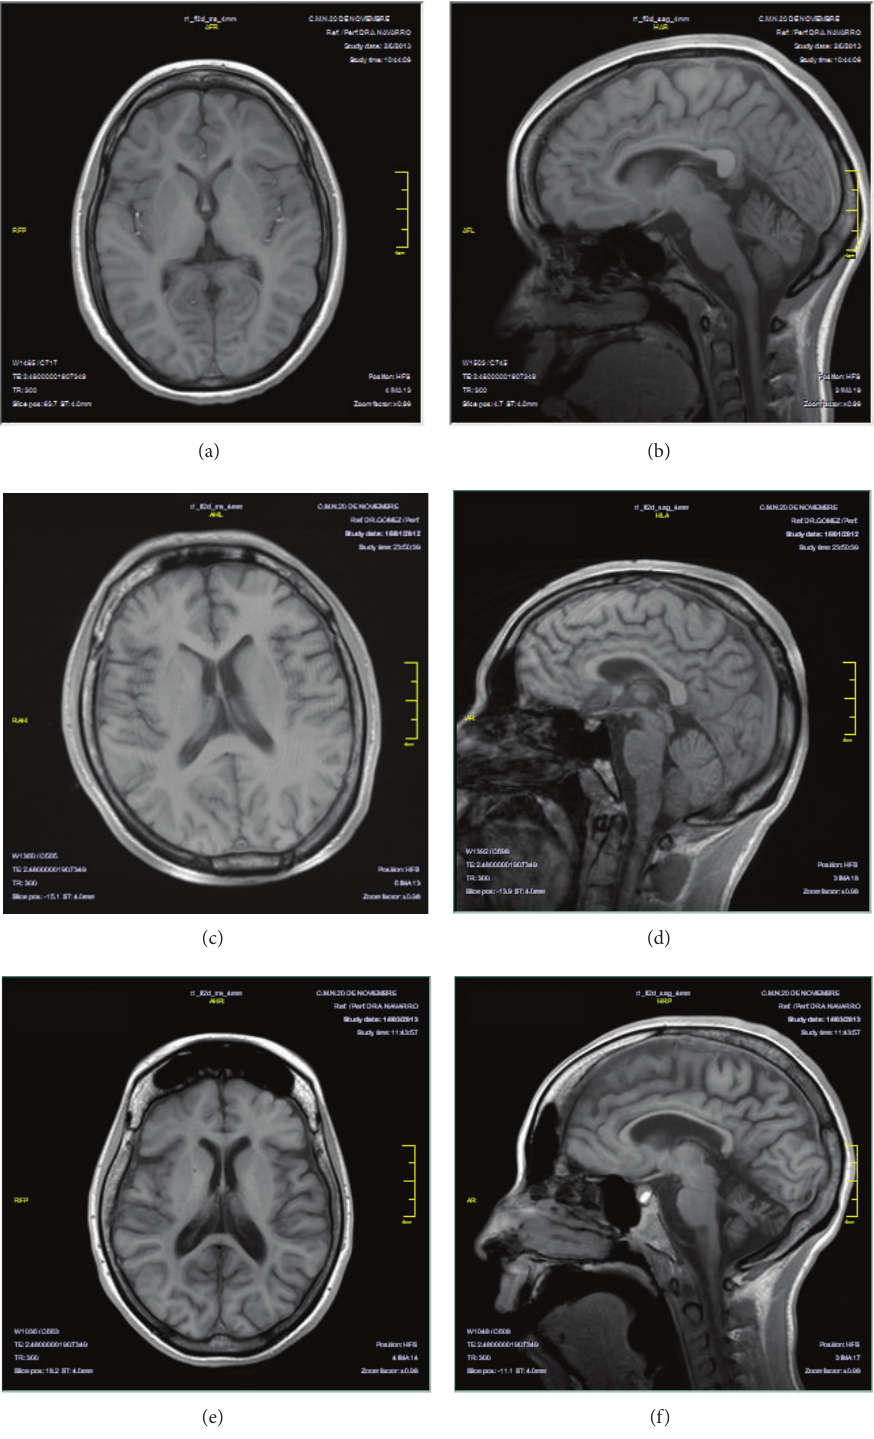
Figure 1: Sagittal and axial T1-weighted MRI images of Case 1 (a, b), Case 2 (c, d), and Case 3 (e, f), showing cortical atrophy (a, c, e) in all and thinning of corpus callosum in Case 1 (b) and Case 3 (f), with marked cerebellar atrophy and frontal hemispheres atrophy